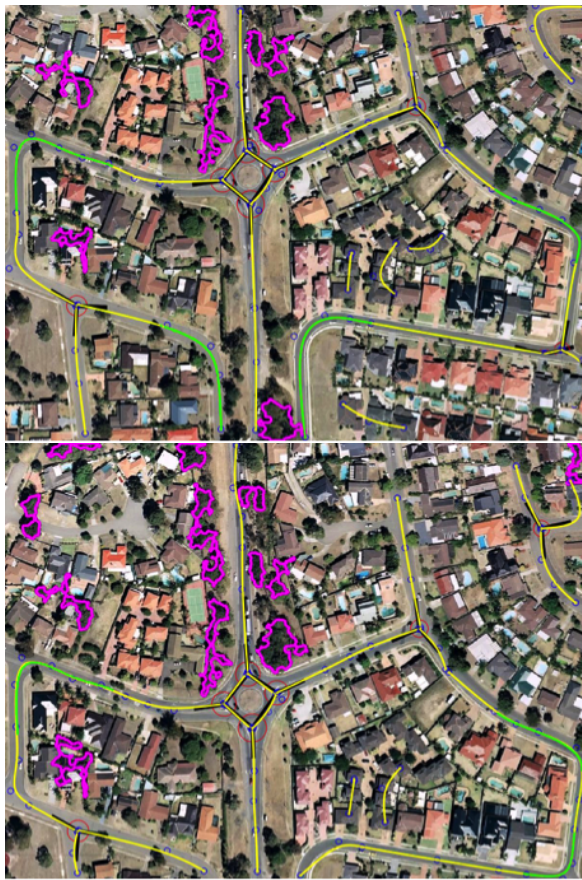
Figure 11: Splines detected in the frame (shown in yellow) com- pared to priority matching spline (green).